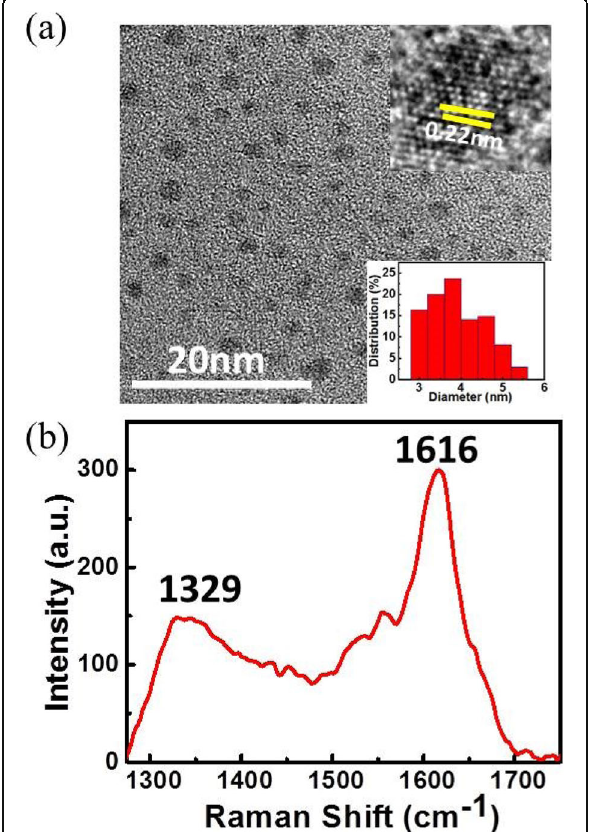
Fig. 2 ( a ) TEM image of un-passivated NDs: the top inset corresponds to the HRTEM image of NDs, and the bottom inset corresponds to their size distribution of NDs. ( b ) Raman spectrum of un-passivated NDs